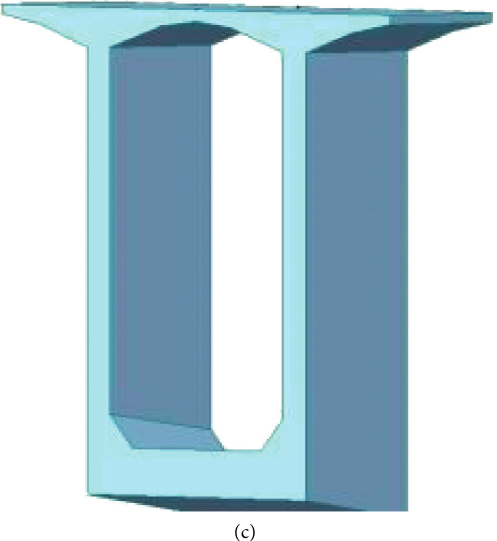
Figure 9: Finite element model of Labajin Bridge: (a) overall model; (b) pier element; (c) girder element.